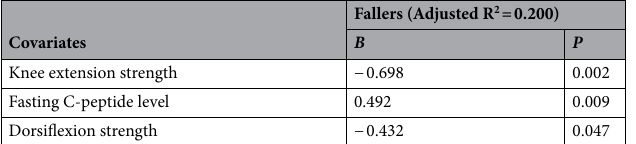
Table 4. Multivariate association of fall-related variables with clinical parameters in stepwise logistic regression analysis. Covariates: sex, fasting C-peptide levels, impaired vibratory sensation, presence of proliferative retinopathy, past history of stroke, taking sulfonylureas at discharge, skeletal muscle percentage, body fat percentage, knee extension strength, knee extension endurance, dorsiflexion strength, toe pinch force, grip strength, index of postural stability, and one-leg standing time.